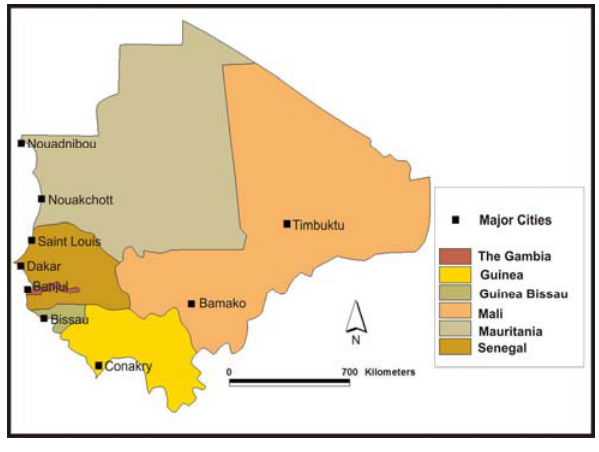
Figure 1 : the Study Area: The Senegal River Basin Nations